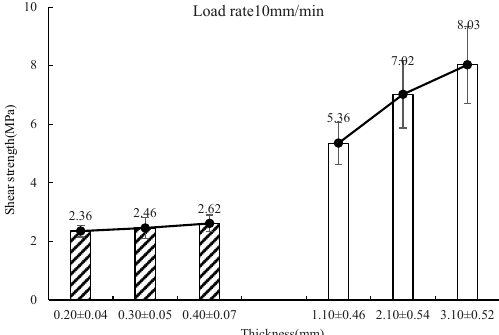
Figure 20. Shear strength of wakame under different thickness.